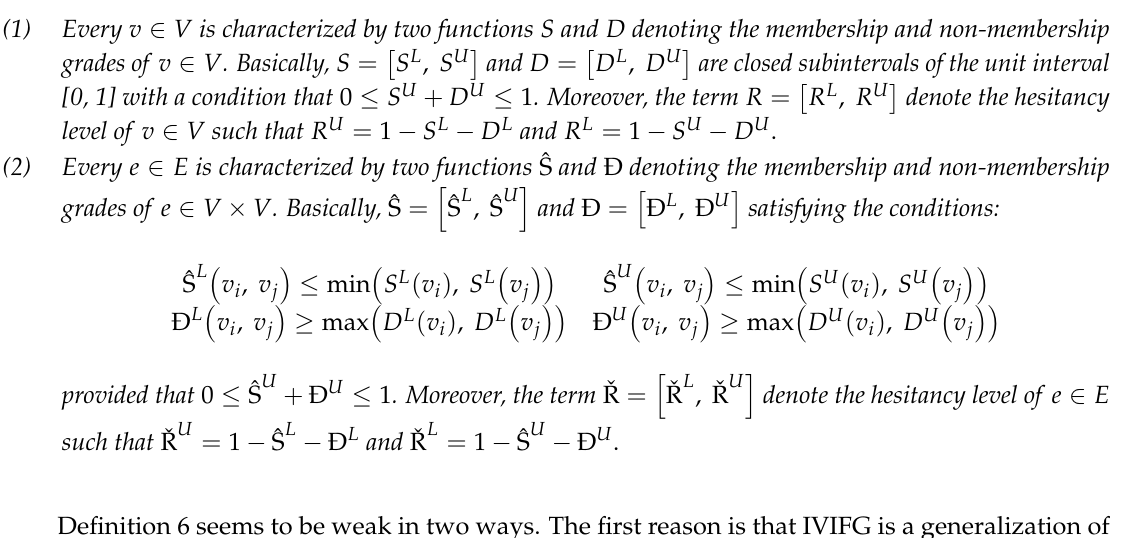
Figure 6. Interval-valued intuitionistic fuzzy graph ( IVIFG) obtained using Definition 6 with undefined intervals.